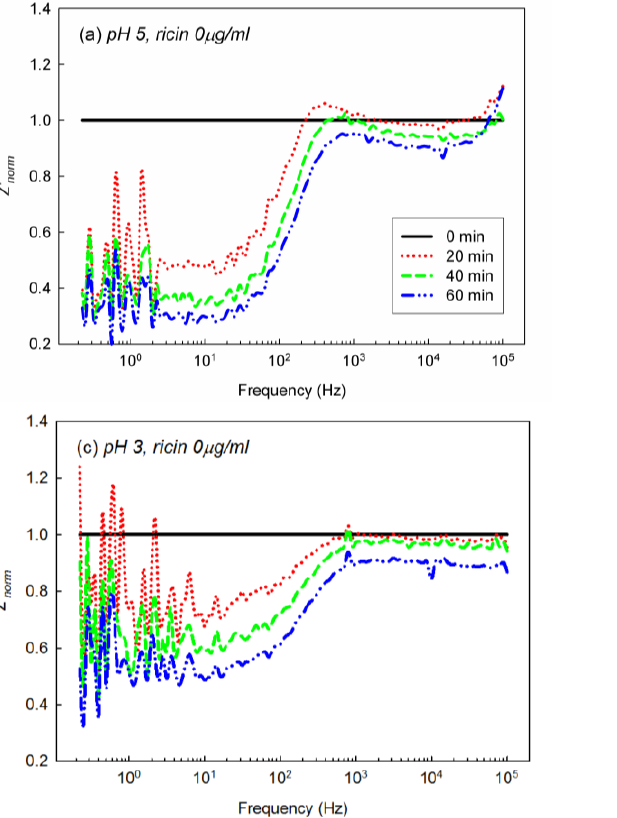
Figure 6. Z’ spectra from EIS analysis of EII with the different treatment of Ag norm concentration; at pH 5, (a) 0 μg/mL, (b) 1 μg/mL of Ag; and at pH 3, (c) 0 μg/mL, (d) 1 μg/mL of Ag. Ricin, the biological toxin, was used as Ag of